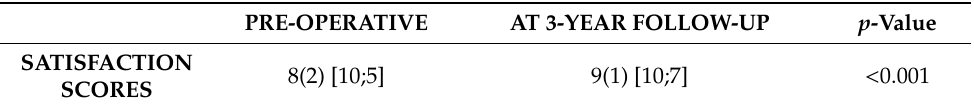
Table 5. Comparison between satisfaction scores given seven days after surgery and given at